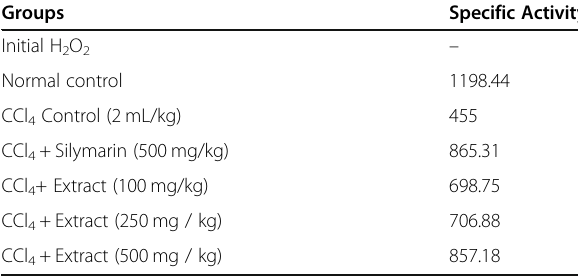
Table 6 Effect of ethanol fruit extract of F. benghalensis on the activity of the antioxidant enzyme (Catalase) in goat liver after Carbon Tetrachloride (CCl 4 ) administration Groups Specific